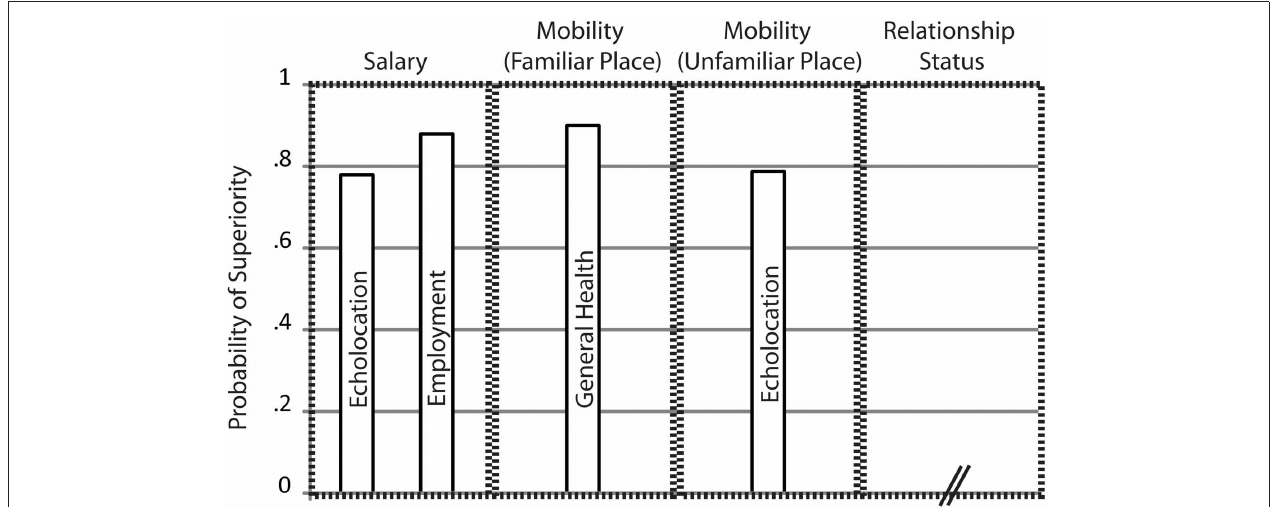
FIGURE 1 | Summary of Results. Bars indicate non-parametric measures of effect-size, i.e., Probability of Superiority as suggested by Grissom and Kim (2012), for those predictors for which both linear regression coefficients and non-parametric tests were significant. Predictors are listed separately for variables “Salary,” “Mobility in Familiar Places,” “Mobility in Unfamiliar Places,” and “Relationship Status.” For the variable “Relationship Status” no predictor contributed significantly. For the other variables names of significant